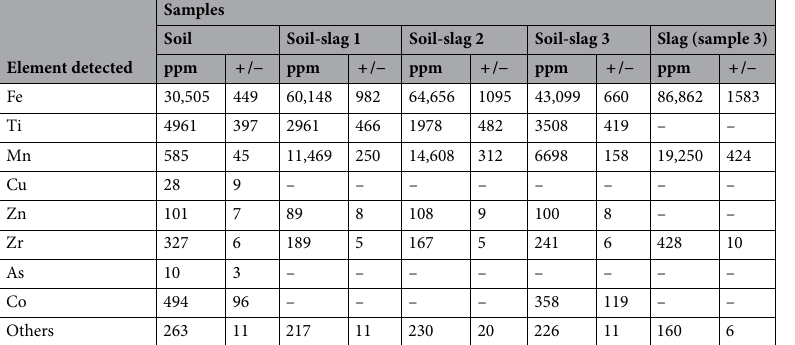
Table 2. XRF analysis of the soil-slag samples.